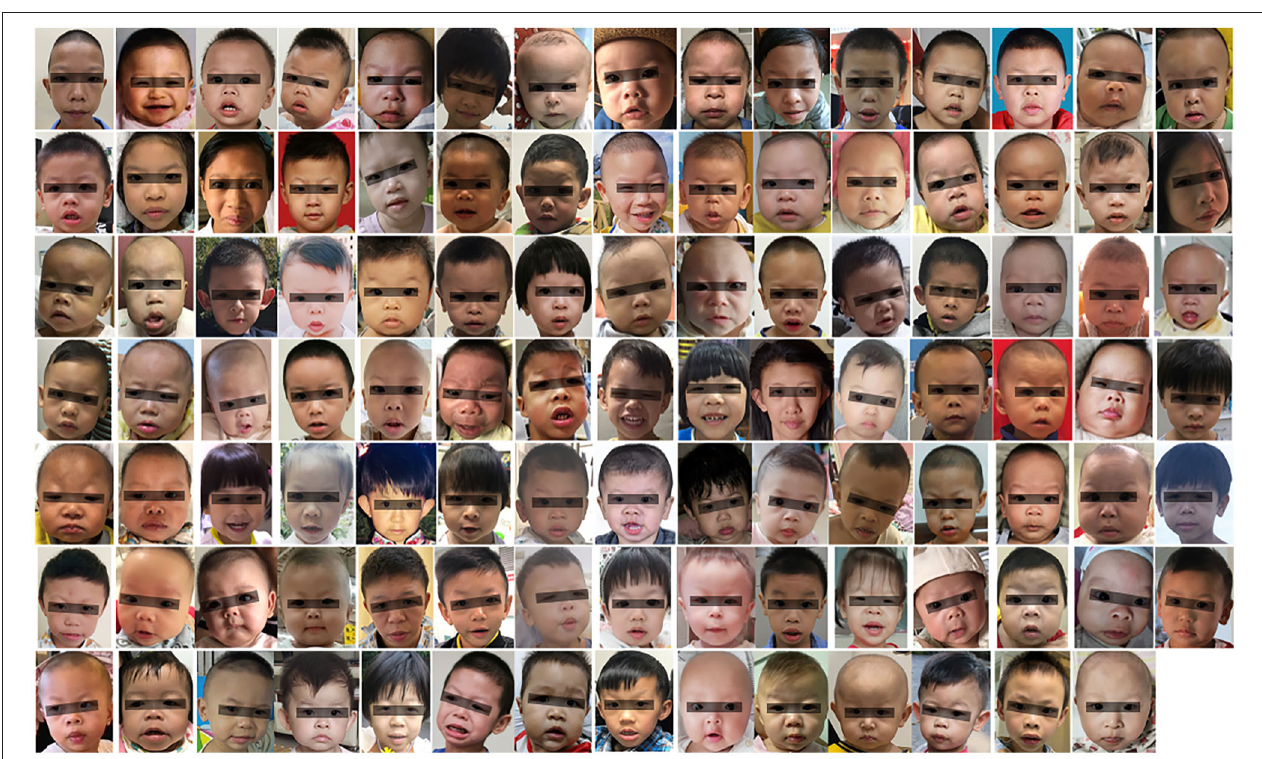
FIGURE 1 | Facial appearance of WBS patients (104 cases). The black bar is used to protect privacy.